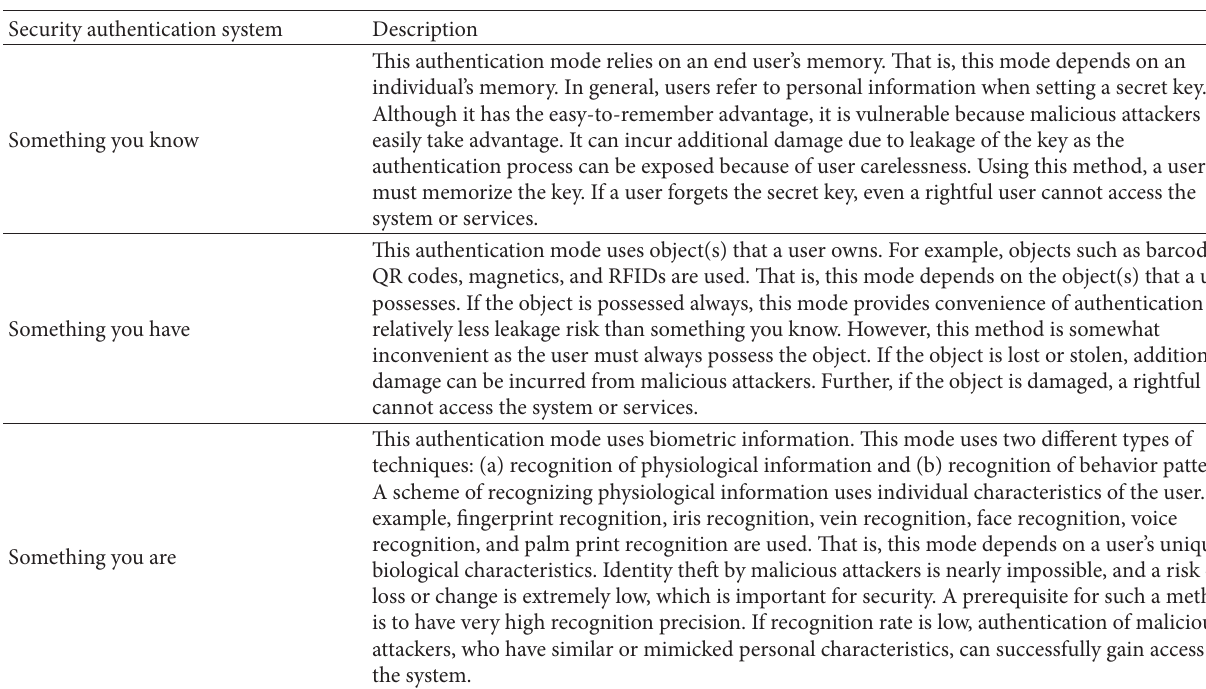
Table 1: Security authentication systems and their descriptions.